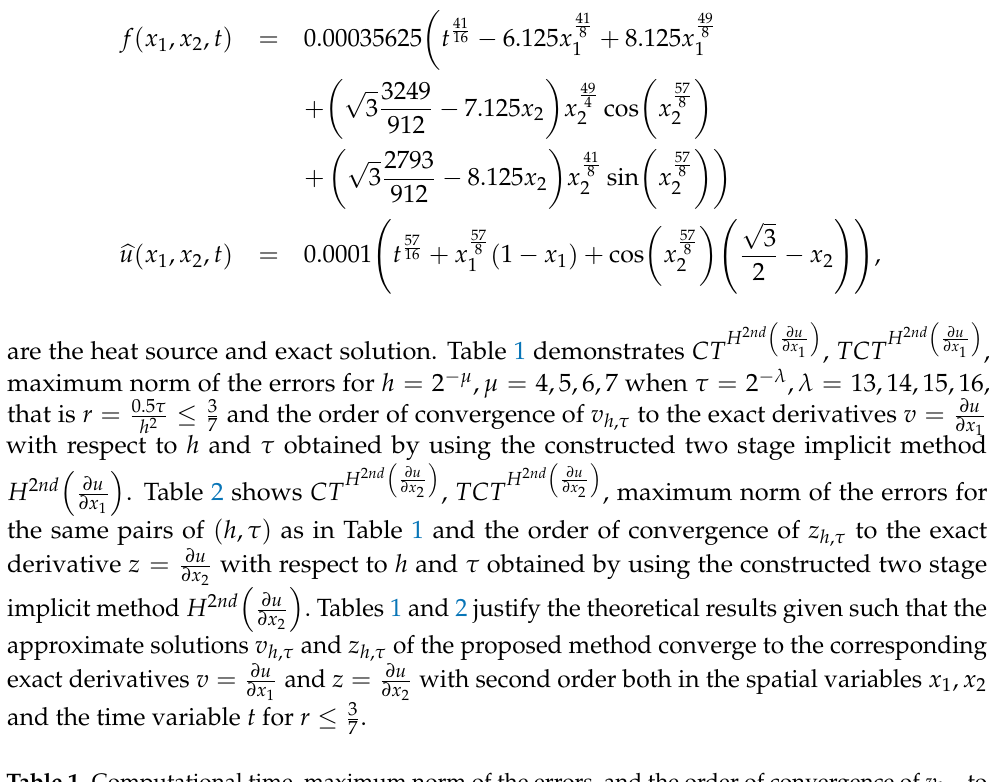
≤ 3 when r = 0.5 τ . 7 ∂ x 1 h 2